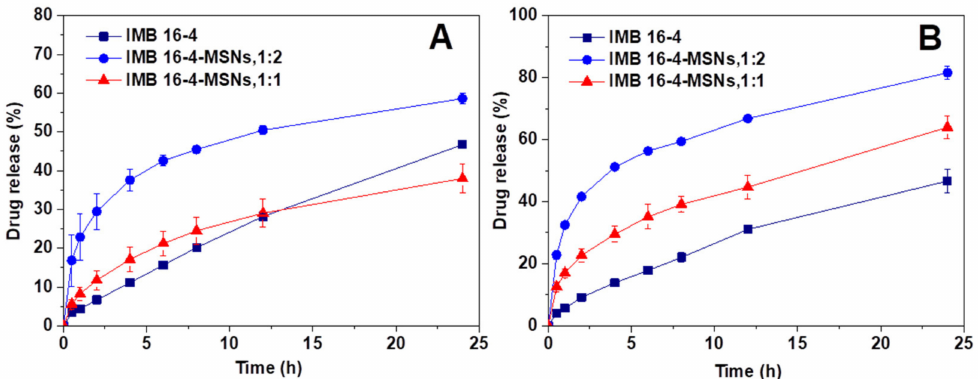
Figure 6. Dissolution profiles of IMB16-4 and loaded samples in pH 1.0 hydrochloric acid containing 3% SDS ( A ) and pH 6.8 phosphate buffer solutions containing 3% SDS ( B ). Each data point represents the mean ± SD of three determinations.